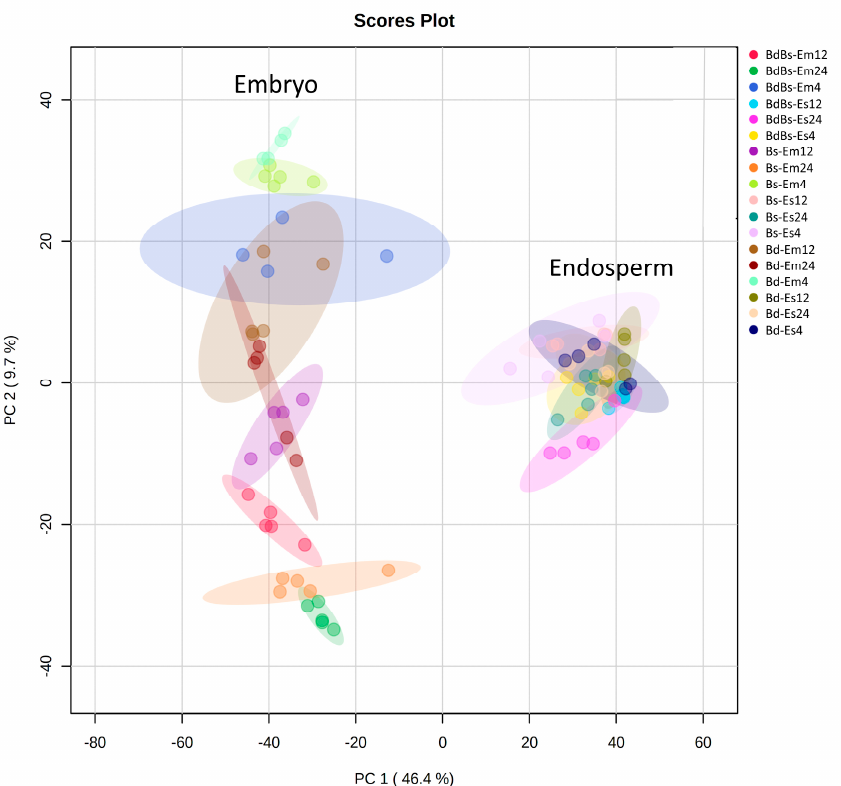
Figure 2. PCA (principal component analysis) of embryo (Em) and endosperm (Es) metabolites in B. distachyon Bd21 (Bd), B. stacei ABR114 (Bs), and B. hybridum ABR113 (BdBs) at 4, 12, and 24 h